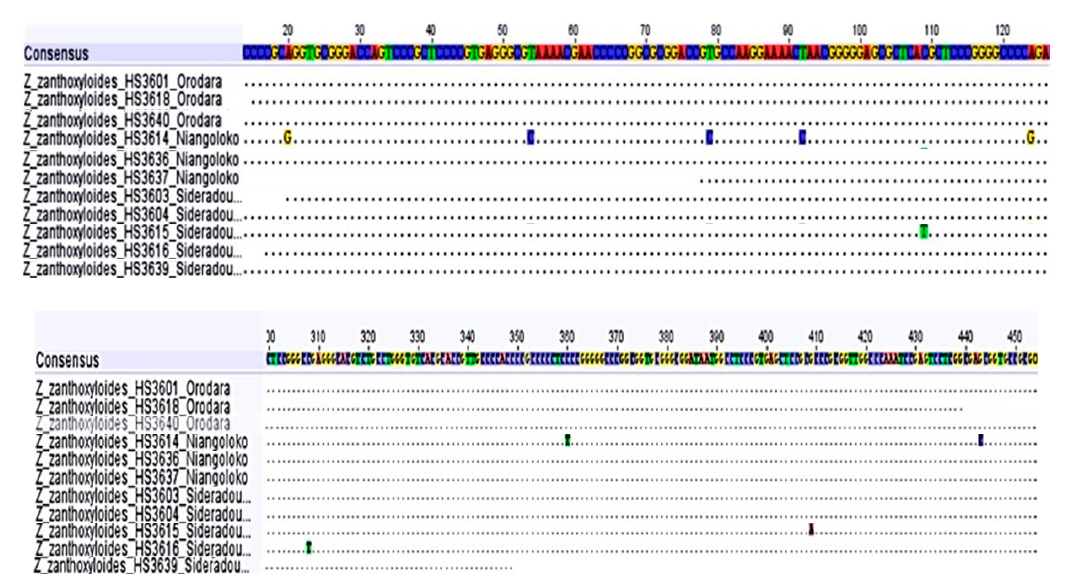
Figure 7. ITS alignment of Z. zanthoxyloides (partly).